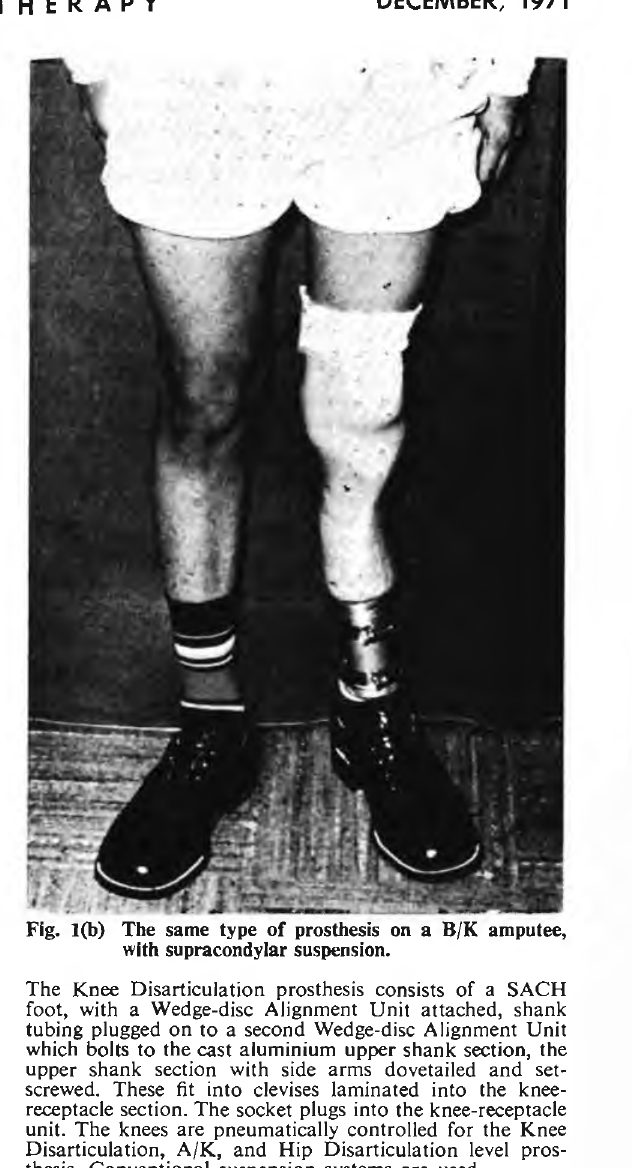
Fig. 1(b) The same type of prosthesis on a B/K amputee, with supracondylar suspension. The Knee Disarticulation prosthesis consists of a SACH foot, with a Wedge-disc Alignment Unit attached, shank tubing plugged on to a second Wedge-disc Alignment Unit which bolts to the cast aluminium upper shank section, the upper shank section with side arms dovetailed and set- screwed. These fit into clevises laminated into the knee- receptacle section. The socket plugs into the knee-receptacle unit. The knees are pneumatically controlled for the Knee Disarticulation, A/K, and Hip Disarticulation level pros­ thesis. Conventional suspension systems are used. To date, over 300 B/K amputees have been provided with modular prostheses in Winnipeg. Approximately 150 A/K amputees have received them. About two dozen H/D amputees use them. No knee disarticulation amputees have yet been fitted with the entire system worked out for them, although half a dozen are wearing a preliminary design which includes BOCK side joints, plastic laminate housings for the attachment of the lower side arms, and the